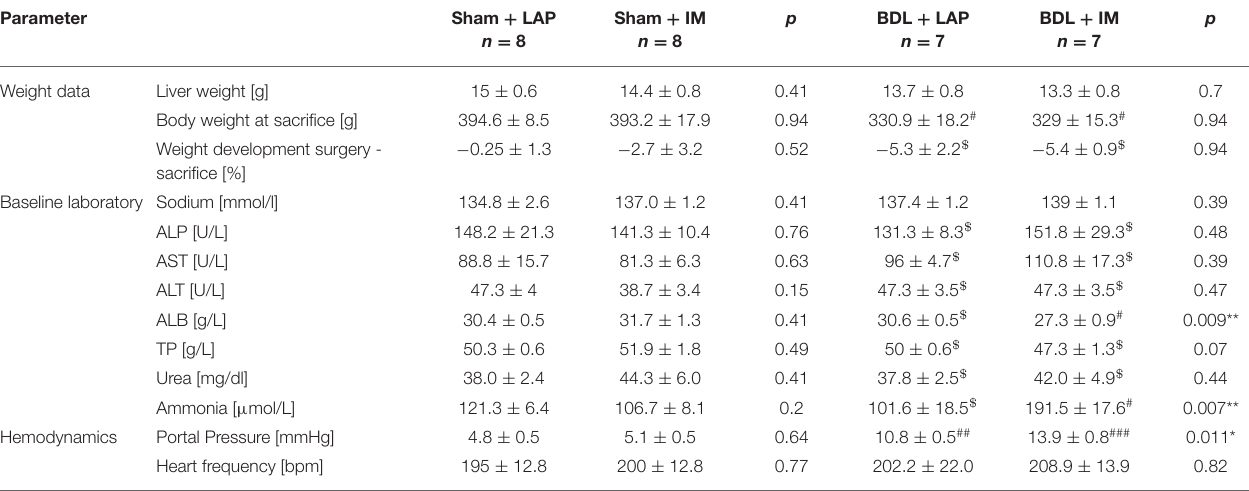
TABLE 1A | General characteristics and clinical data of rats undergoing Sham/BDL at sacrifice 2 days after IM/LAP. Parameter Sham + LAP